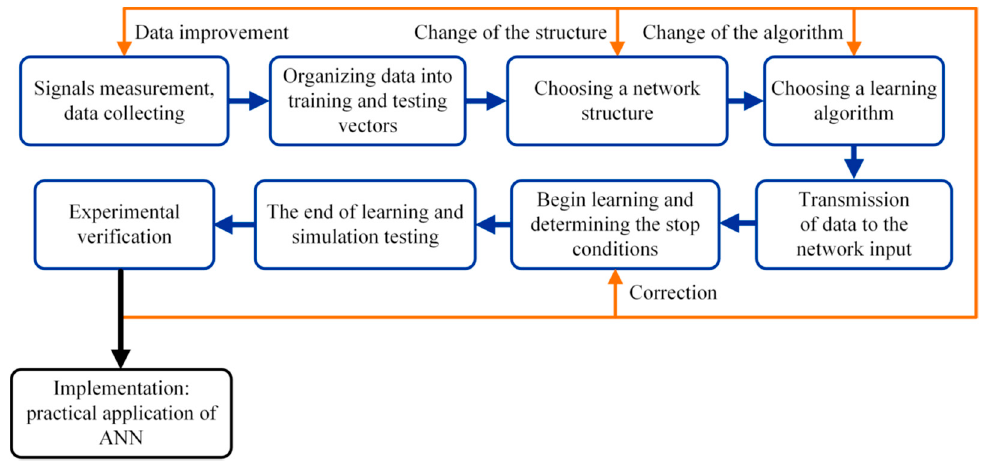
Figure 9. Neural network design cycle [17].